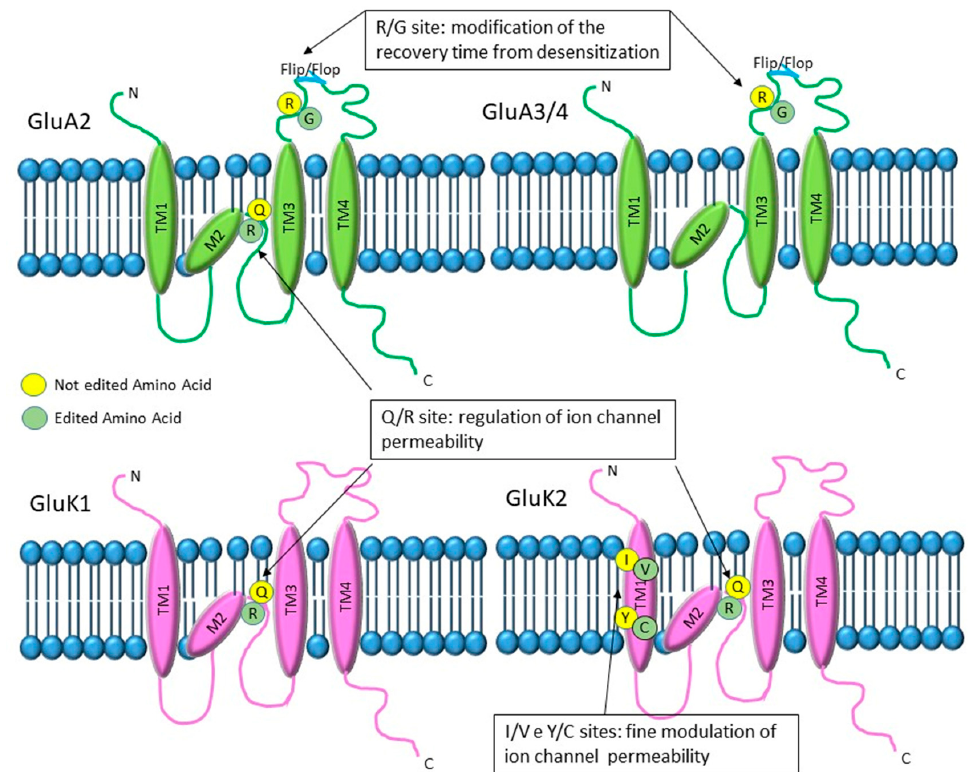
Figure 2. Graphical representation of the alfa-Amino-(3-Idrossi-5-Metil-4-isoxazole) propionate (AMPA) and Kainate glutamate receptors and their editing sites. GluA2/3/4 AMPA subunits have an edited site that converts arginine to glycine (R/G) located in the extracellular loop adjacent to the neurotransmitter binding site. Editing at this site enhances the recovery time from desensitization. In addition, GluA2 subunit and kainate GluK1 and GluK2 have a Q/R editing site, located in the second membrane domain, inside the channel pore. The Q/R site is involved in the regulation of ion channel permeability and is always fully edited in GluA2, whereas it shows variable levels of editing for the kainate receptor subunits. Finally, the GluK2 subunit presents two additional editing sites (I/V and Y/C) localized in the first transmembrane domain and involved in the fine tuning of ion channel permeability.